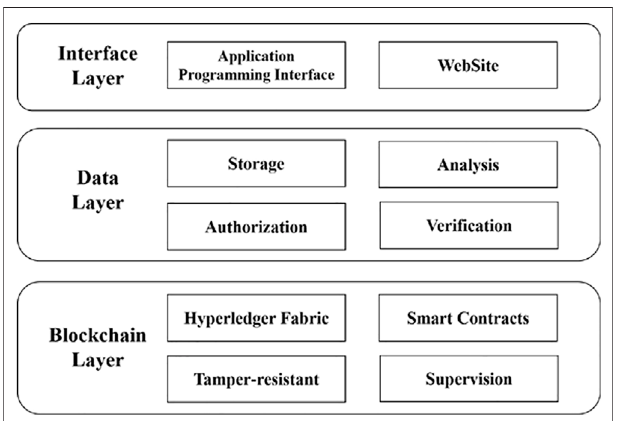
FIGURE 1 | Structure of the personal health data management framework. The framework was composed of interface layer, data layer, and blockchain layer.